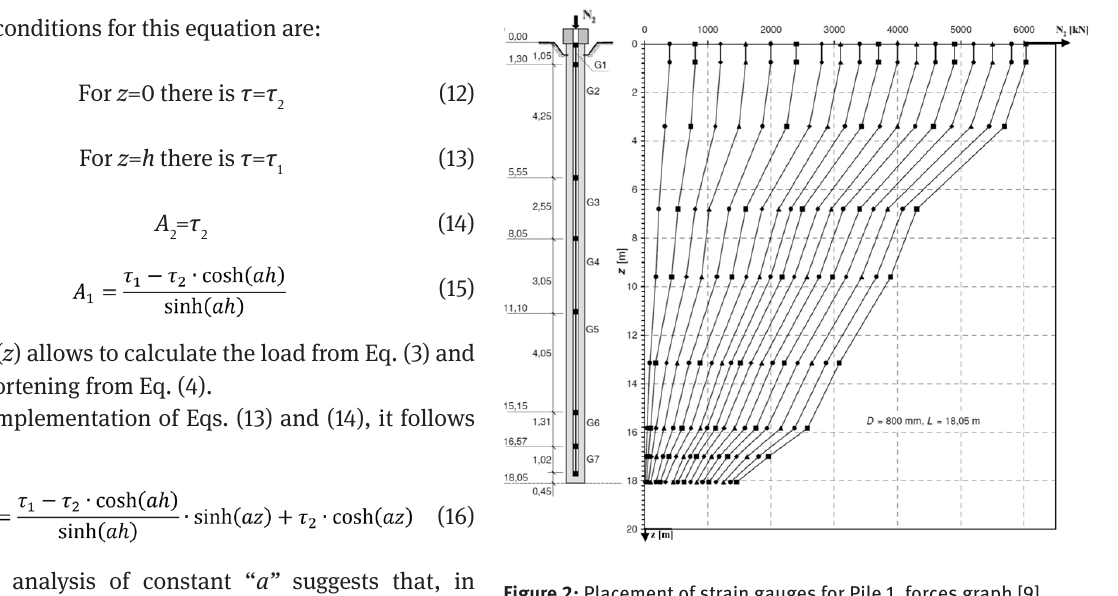
Figure 2: Placement of strain gauges for Pile 1, forces graph